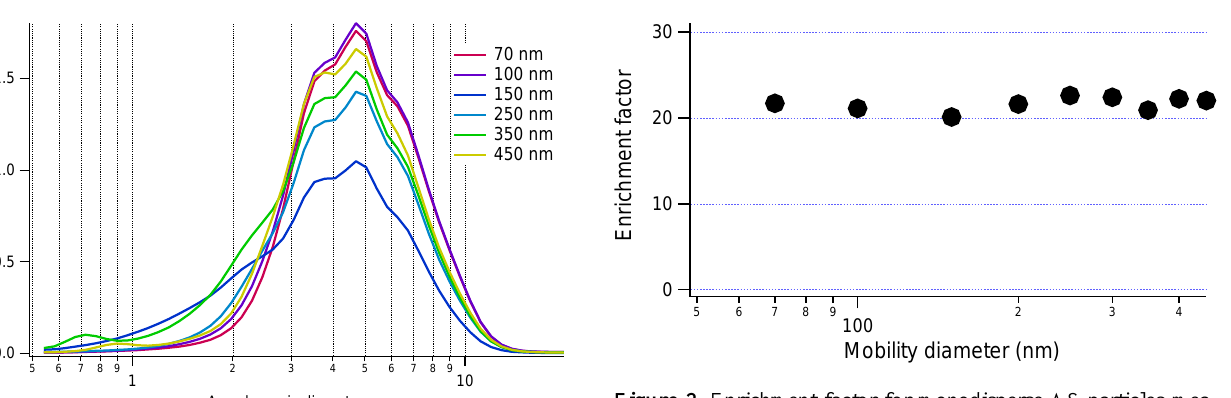
Figure 2. Enrichment factor for monodisperse AS particles mea- sured with the CPC. Theoretical enrichment factor was